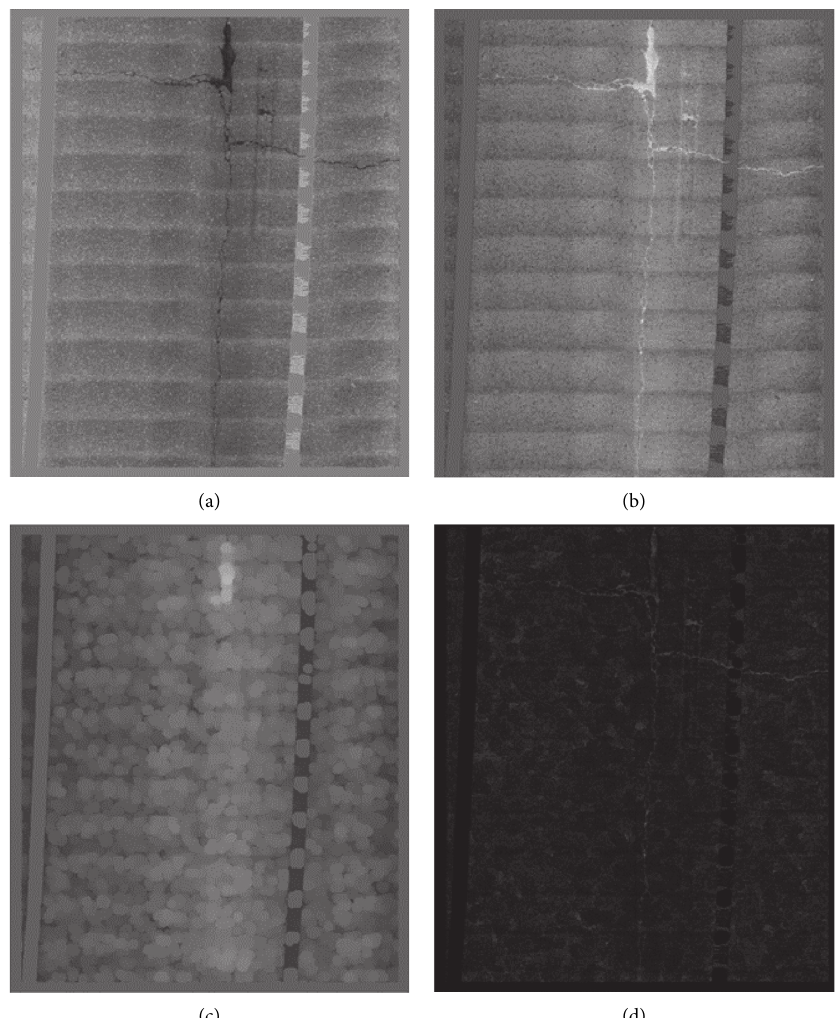
Figure 5: Effect of top-hat conversion. (a) Original image. (b) Image after color reversing. (c) Brighter areas in the image. (d) Result of the top-hat